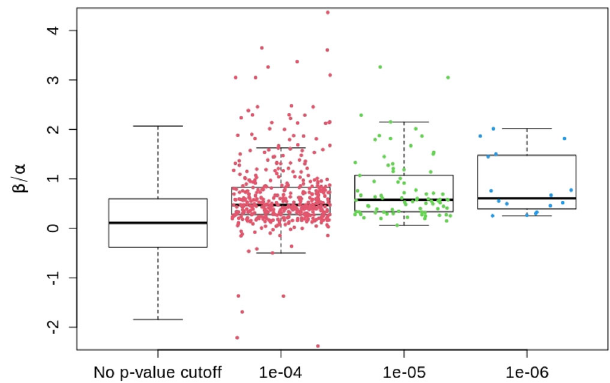
Fig.1|Distributionsoftheprognostictopredictiveeffectsizeratioscalculated from the IMPROVE-IT PGx GWAS summary statistics data with n =5661 unre- latedEuropean samples. The left boxplot shows the distribution of whole genome SNPs (after clumping, m =8,551,930). The right three boxplots show the distribution of top SNPs (after clumping) with their 2df (G+G×T) two-sided test p -values less thanthethree p -valuethresholds1e − 06( m =16),1e − 05( m =81),and1e − 04( m =472), respectively. In each boxplot, the band indicates the median, the box indicates the fi rst and third quartiles, and the whiskers indicate±1.5×interquartile range. Effect size ratios of m SNPs are overlaid on the corresponding boxplot as dot